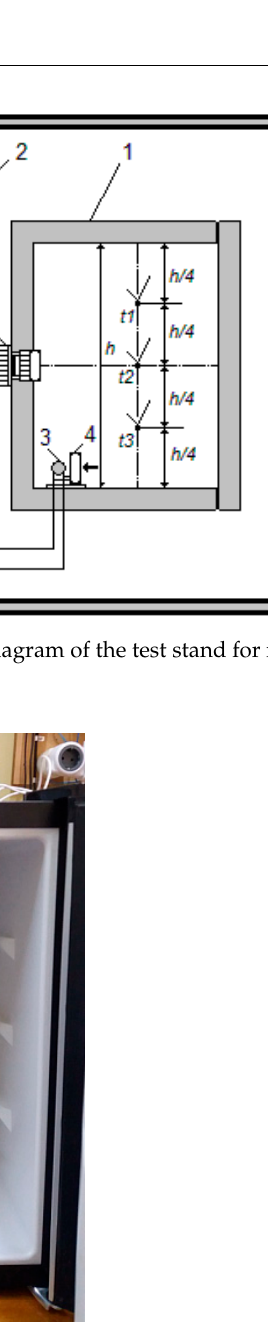
Figure 3. Arrangement of heater and thermocouples in the refrigerator cabinet during the k coeffi- cient measurements.